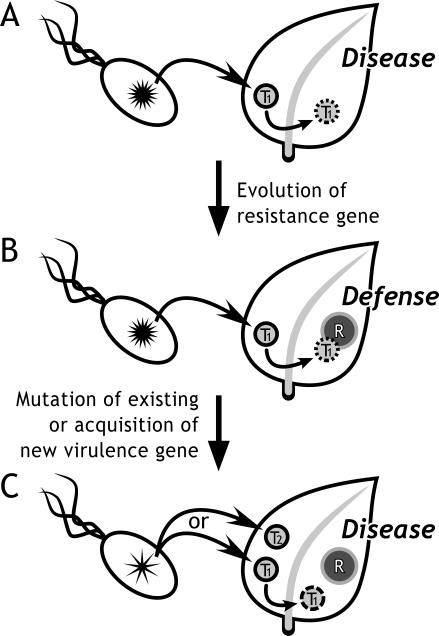
Arms-Race Model(A–C) Star-shaped figures in bacteria represent T3SEs. T1 and T2 are two virulence targets in the host. R is a resistance protein that induces the host-defense response upon recognition of a plant-virulence target modified by a bacterial effector.(A) The pathogen secretes the ancestral HopZ1a T3SE which modifies a host-virulence target and contributes to the disease process.(B) The plant host evolves or acquires an R protein that recognizes the modified target of HopZ1a, and uses this as a cue to induce the defense response, making the plant host resistant to the pathogen.(C) Strong positive selection imposed by the host R protein results in the evolution of modified HopZ T3SEs (e.g., HopZ1b and HopZ1c) or the acquisition of homologs from ecologically similar plant pathogens (e.g., HopZ2 and HopZ3). These T3SEs retain cysteine-protease function, but are not recognized by the R protein, and therefore do not induce a defense response. They may avoid R-protein recognition by either attacking a new virulence target in the host, or by modifying the original target so that it is not recognized by the R protein.